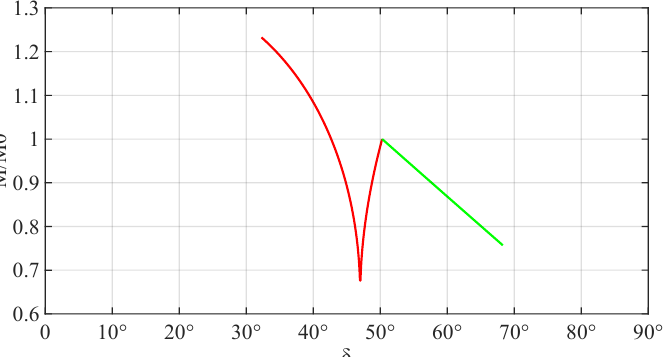
Figure 13. The obstacle height h is 15 mm. Comparison of torque under transformable state C 1 and C 2 M / M 0 (Red: C 1 ; Green: C 2 ).